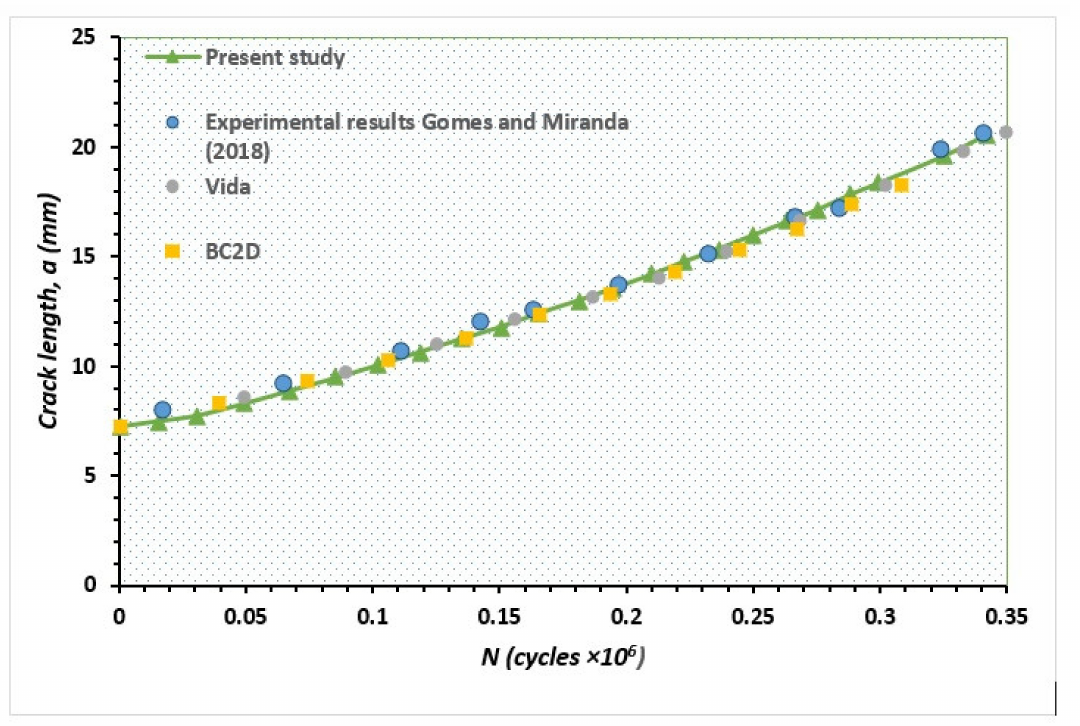
Figure 16. Fatigue life for the modified compact tension specimen